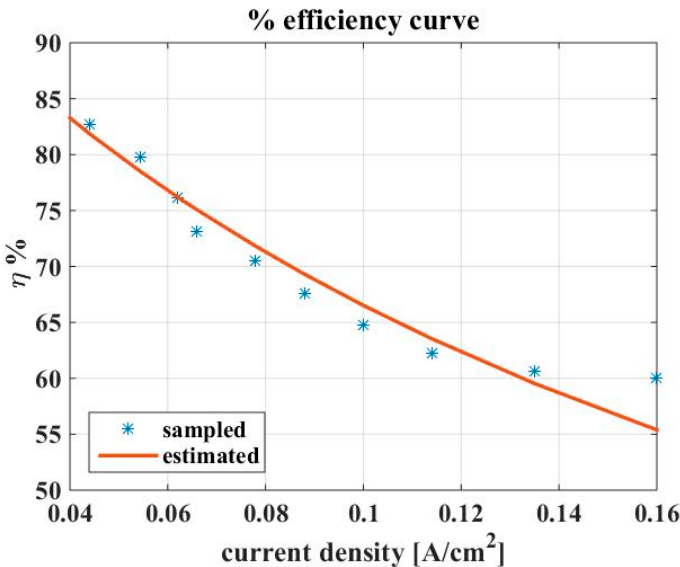
Figure 10. Upper limit of the efficiency for the PEM EL.